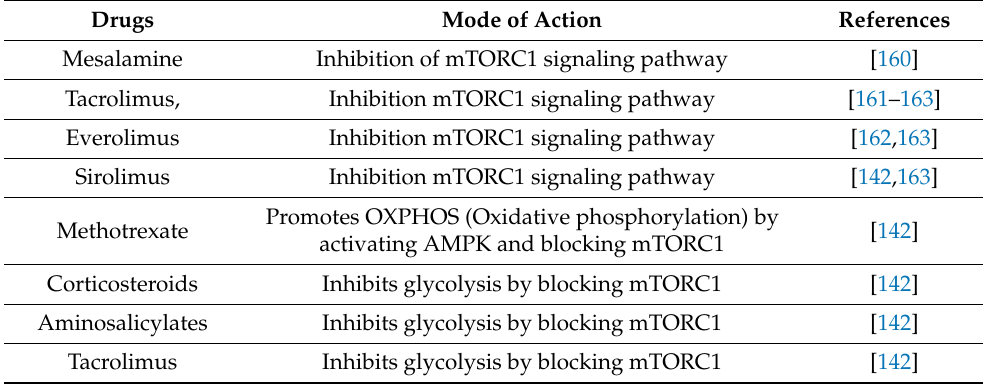
Table 2. mTOR inhibiting drugs for